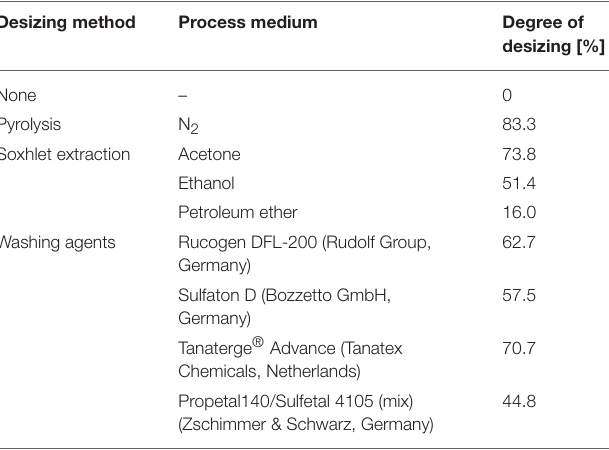
TABLE 3 | Degrees of desizing after application of varying desizing methods for woven fabrics made from CF T300 (initial sizing amount 0.992% w / w ). Desizing method